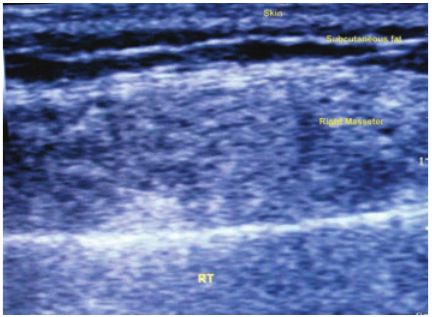
Figure 6: Grey scale sonography showing no evidence of the lesion after a 3-year